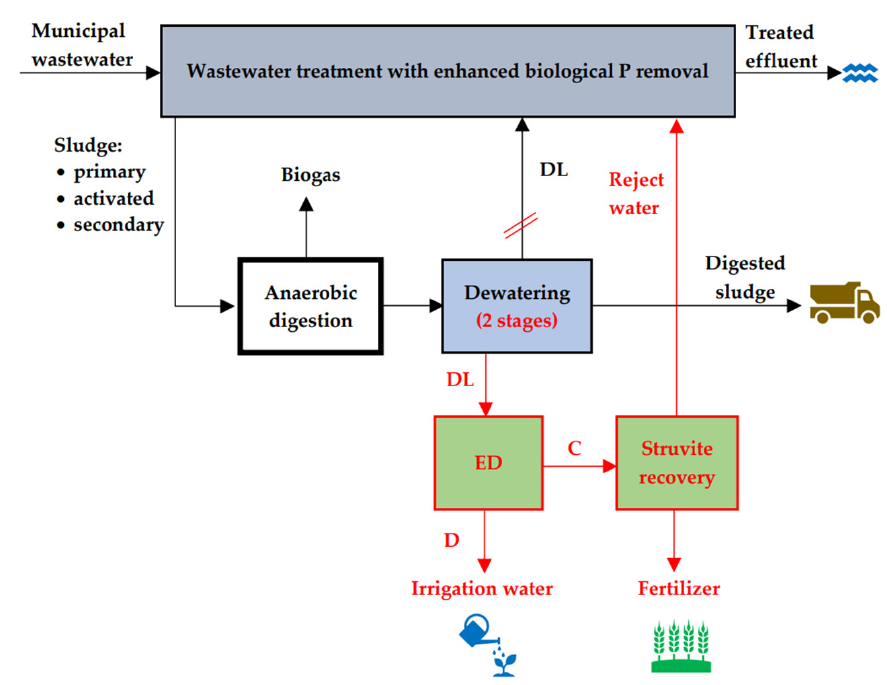
Figure 1. Contrasting the existing WWTP practice and our proposed solution incorporating ED into municipal WWTPs (where: black color describes the existing practice, and red color represents our solution). Note that DL is dewatering liquor, C is concentrate, and D is diluate. DL is further concentrated using electrodialysis (ED). Struvite is precipitated from the concentrate (C), and the reject water is discharged into the inflow into the WWTP. At the same time, the diluate (D) can also be used, for example, as water for irrigation.